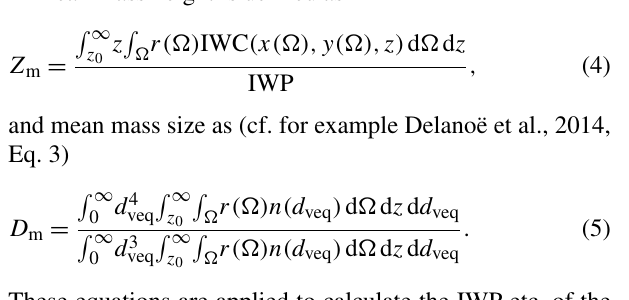
x , y and z are Cartesian coordinates (with arbitrary